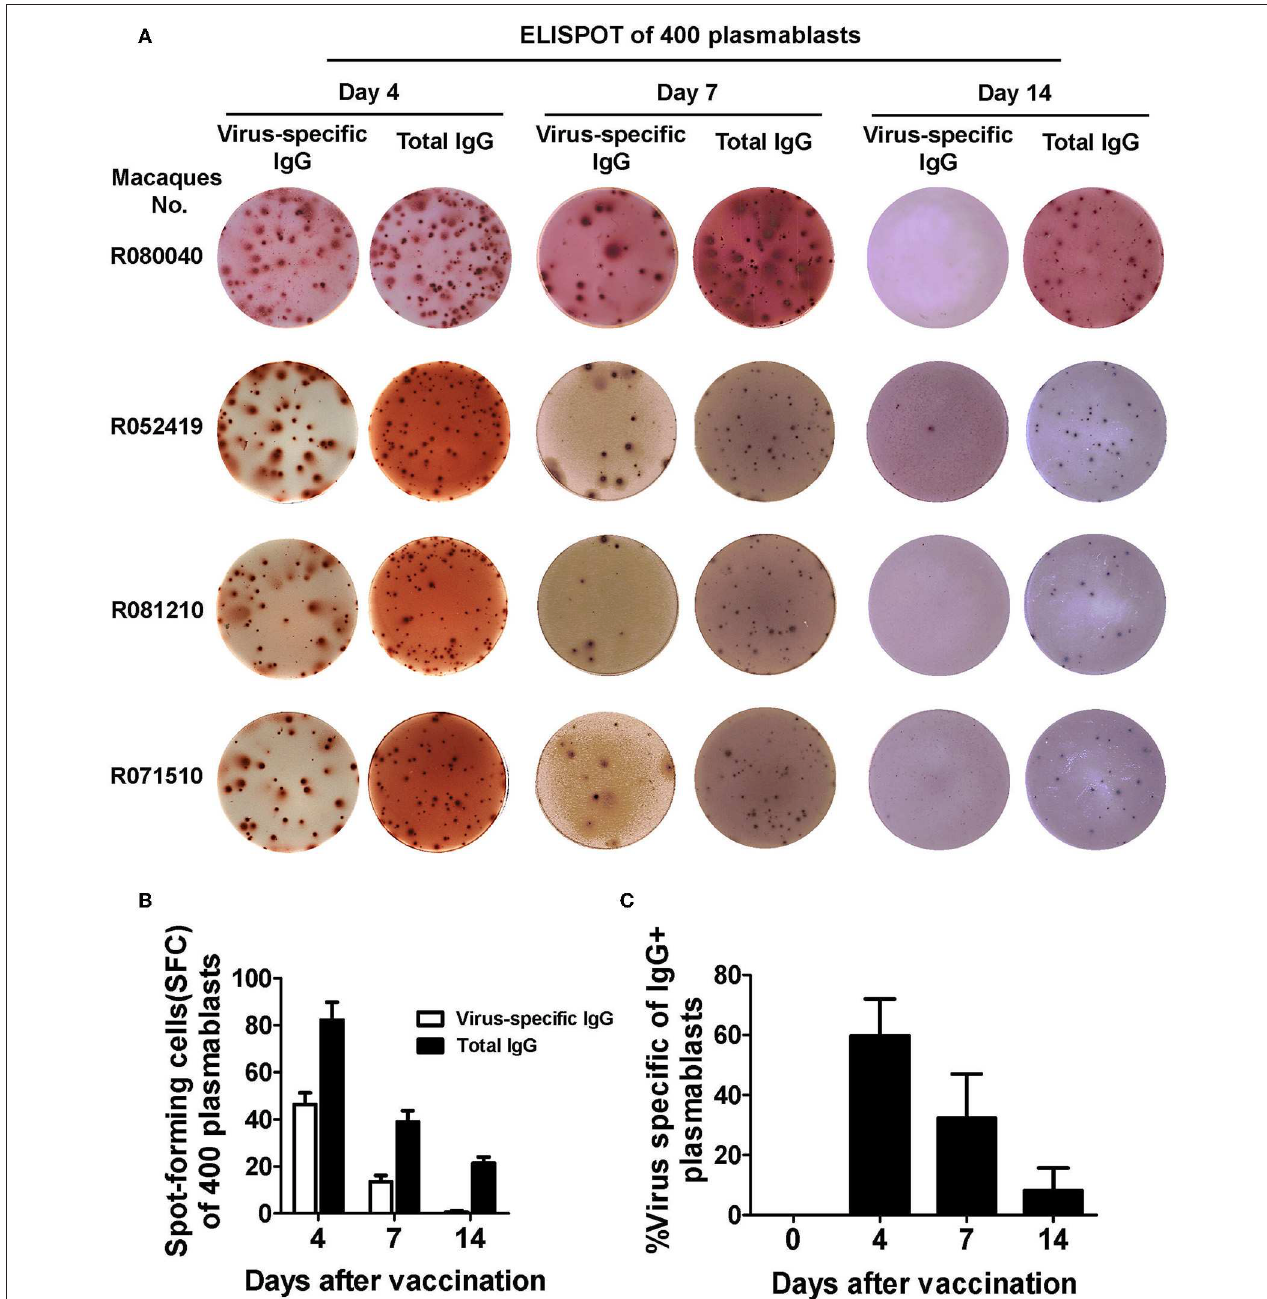
FIGURE 6 | Functional confirmation of antibody-secreting plasmablasts from Chinese rhesus macaques by ELISPOT assay. (A) 400 sorted Chinese rhesus macaque plasmablasts were plated with inactivated influenza virus or anti-human IgG. Representative examples of the ELISPOT assay results for macaque plasmablasts at day 4, 7, and 14 after vaccination (macaque no. R080040, R052419, R081210 and R071510). (B) Spot-forming cells (SFC) secreting virus-specific or total IgG among 400 sorted Chinese rhesus macaque plasmablasts at day 4, 7, and 14 after vaccination ( n = 4, Mean ± SEM). (C) Percentage of influenza virus-specific plasmablasts among IgG-secreting plasmablasts at indicated time points after booster vaccination. The Chinese rhesus macaque plasmablast gating strategy was as follows: CD3 − CD14 − CD56 − CD19 − CD27 − CD20 − / low CD80 + HLA-DR + CD95 + ( n = 6, Mean ± SEM). The experiment has repeated a minimum of three times.